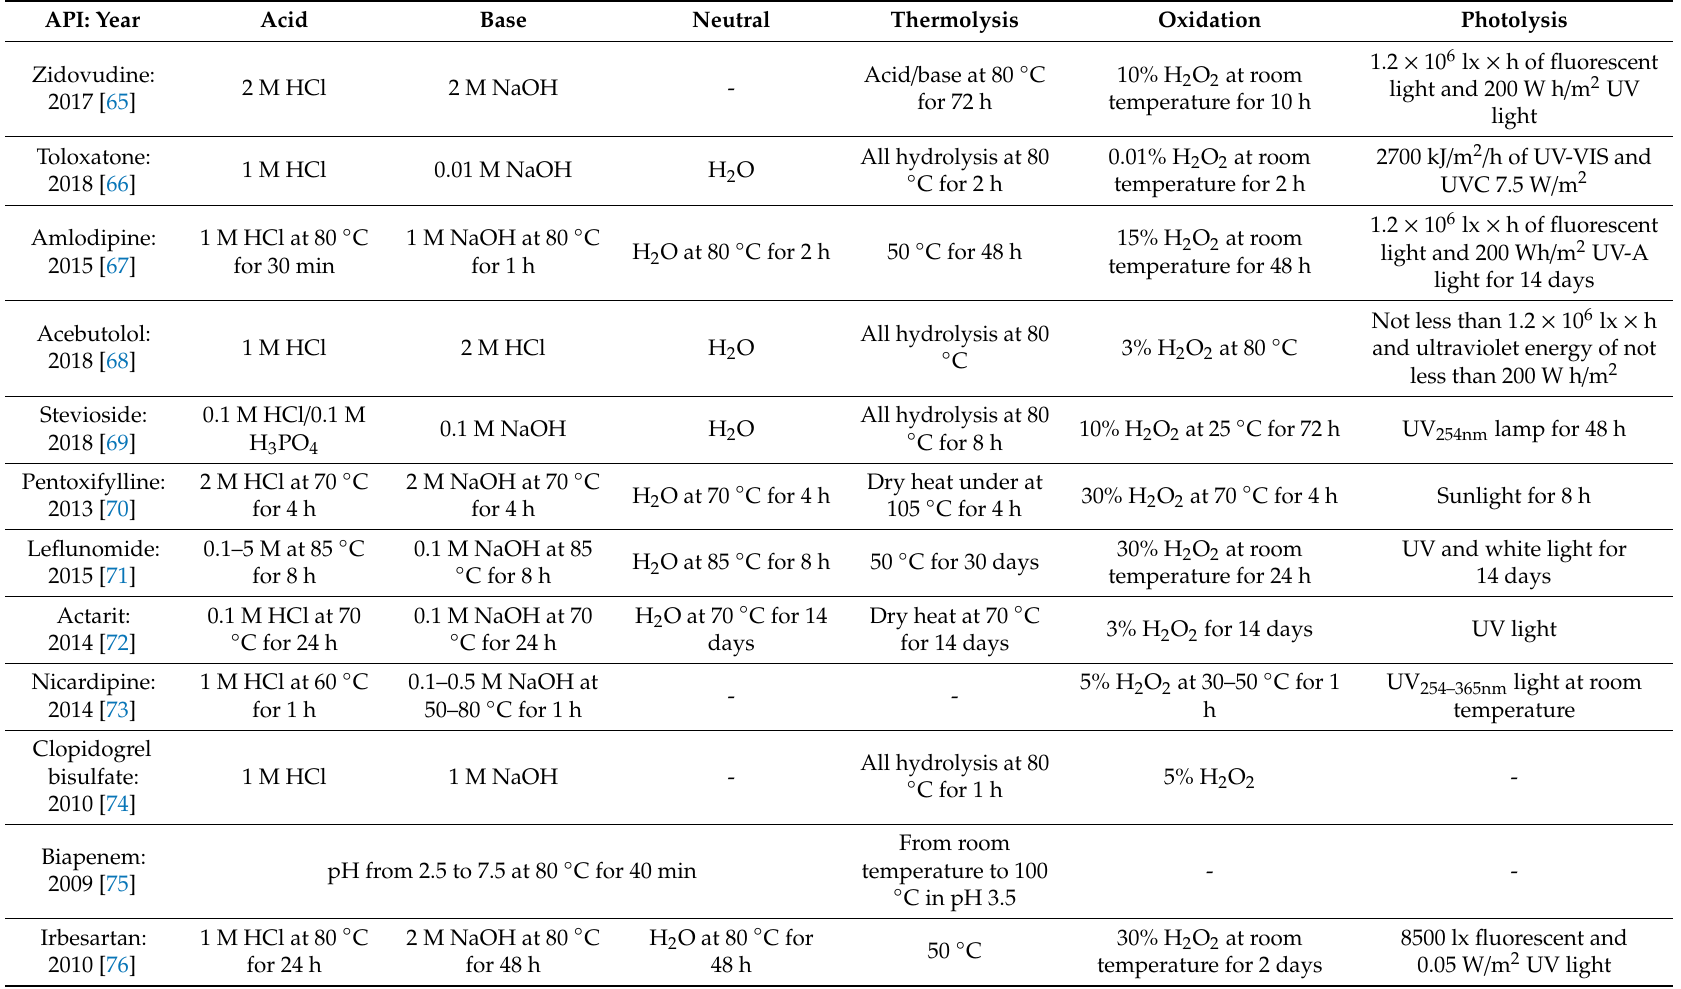
Table 1. Degradation conditions for pharmaceutical drugs in forced degradation